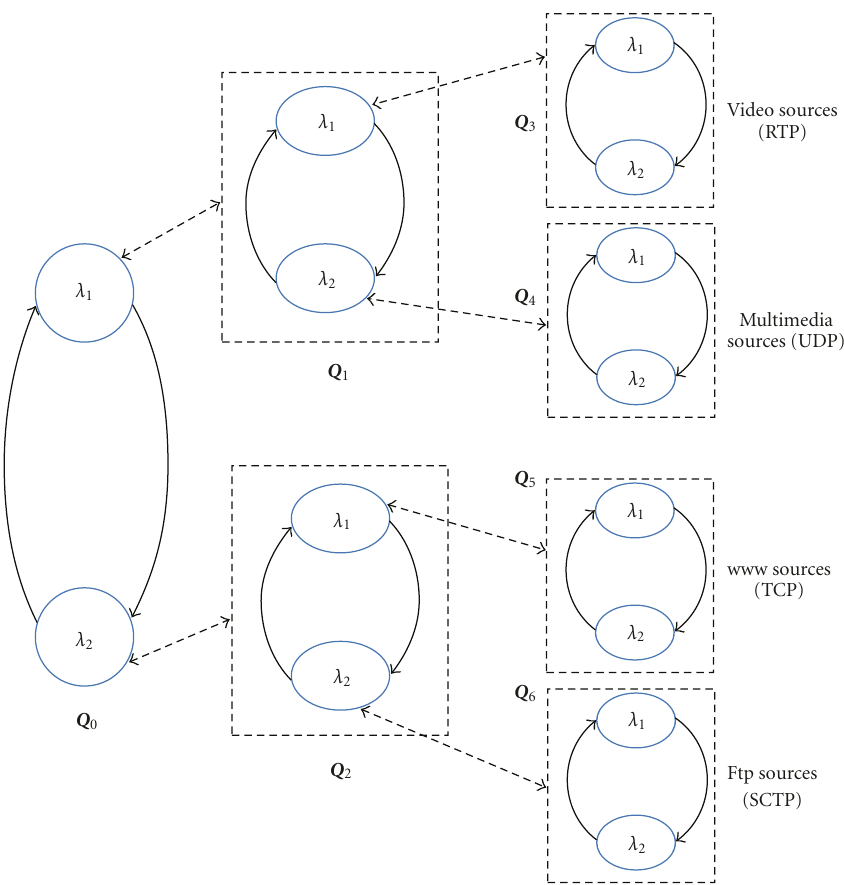
Figure 6: MMPP-8 consisting of three